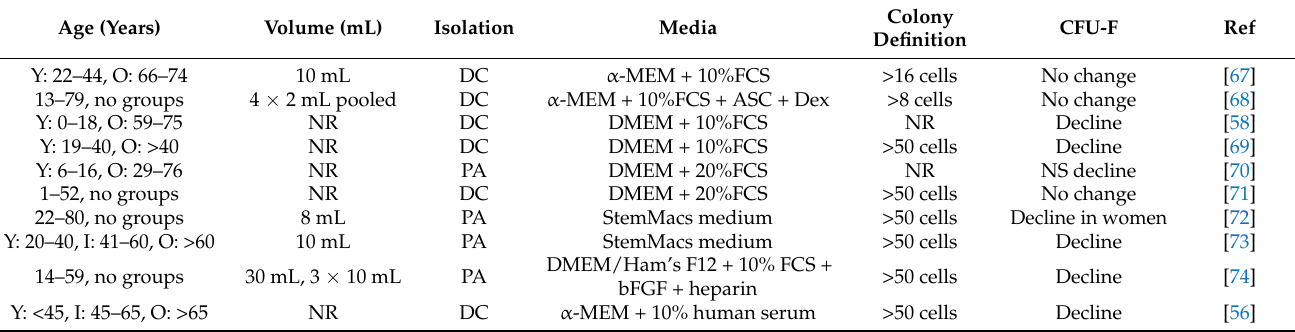
Table 1. List of previous studies investigating age-related changes in the numbers of BM MSCs counted by the CFU-F assay. Age (Years) Volume (mL)